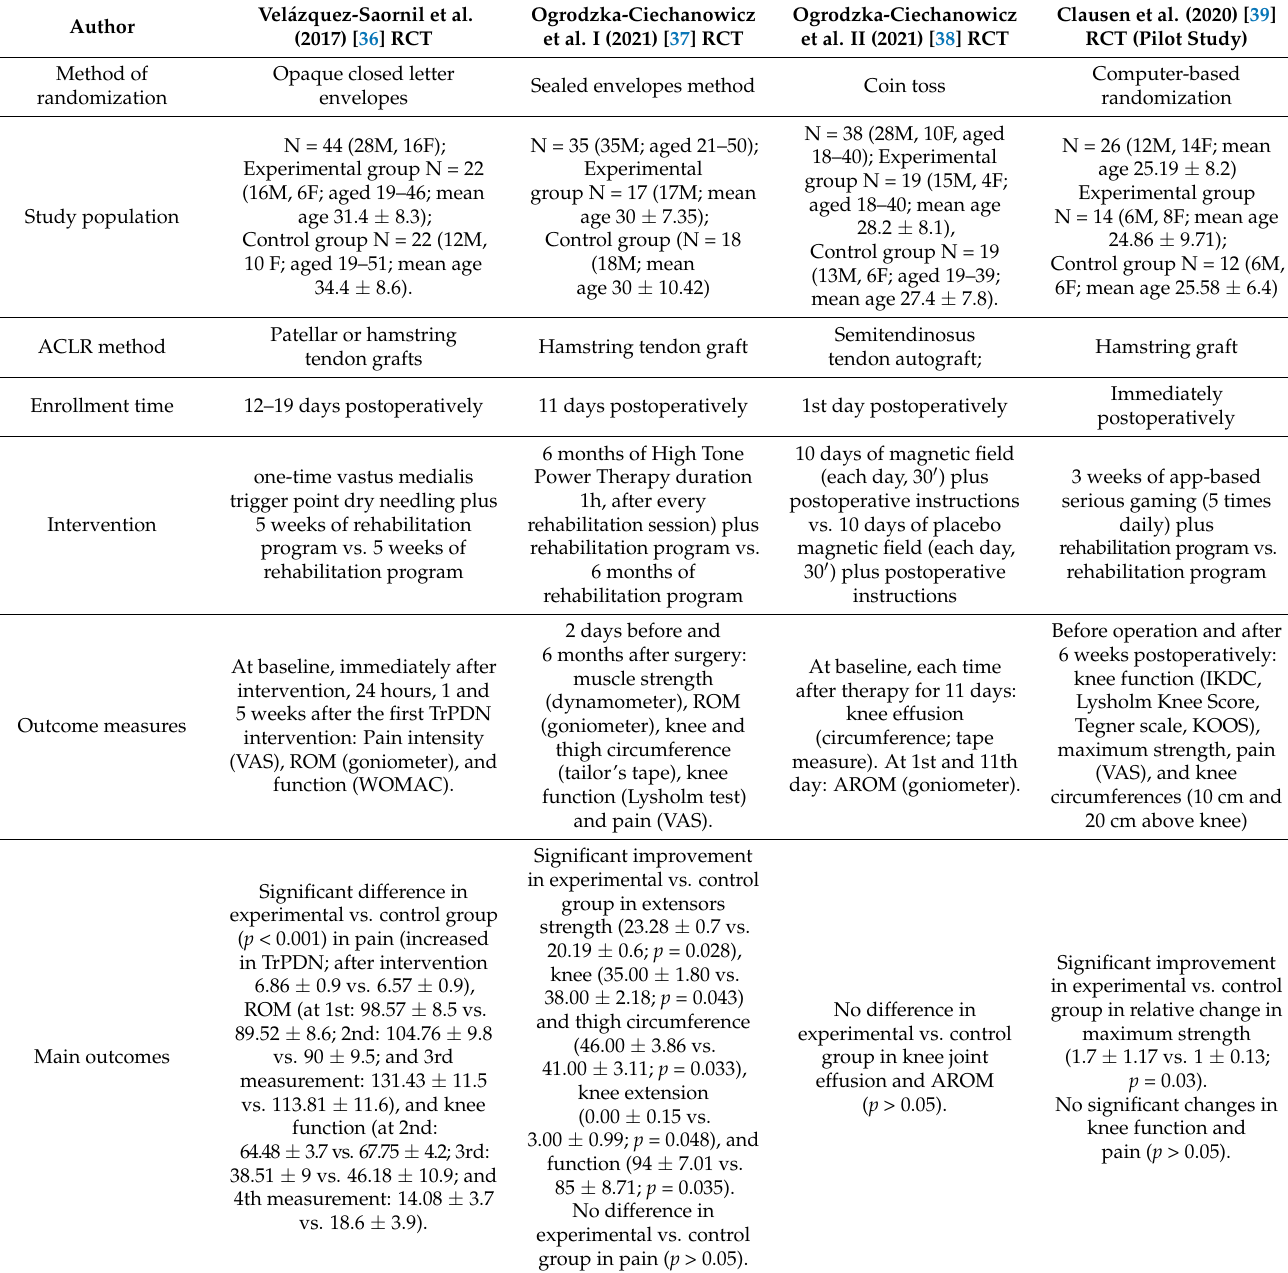
Table 9. Summary of reviewed studies on miscellaneous